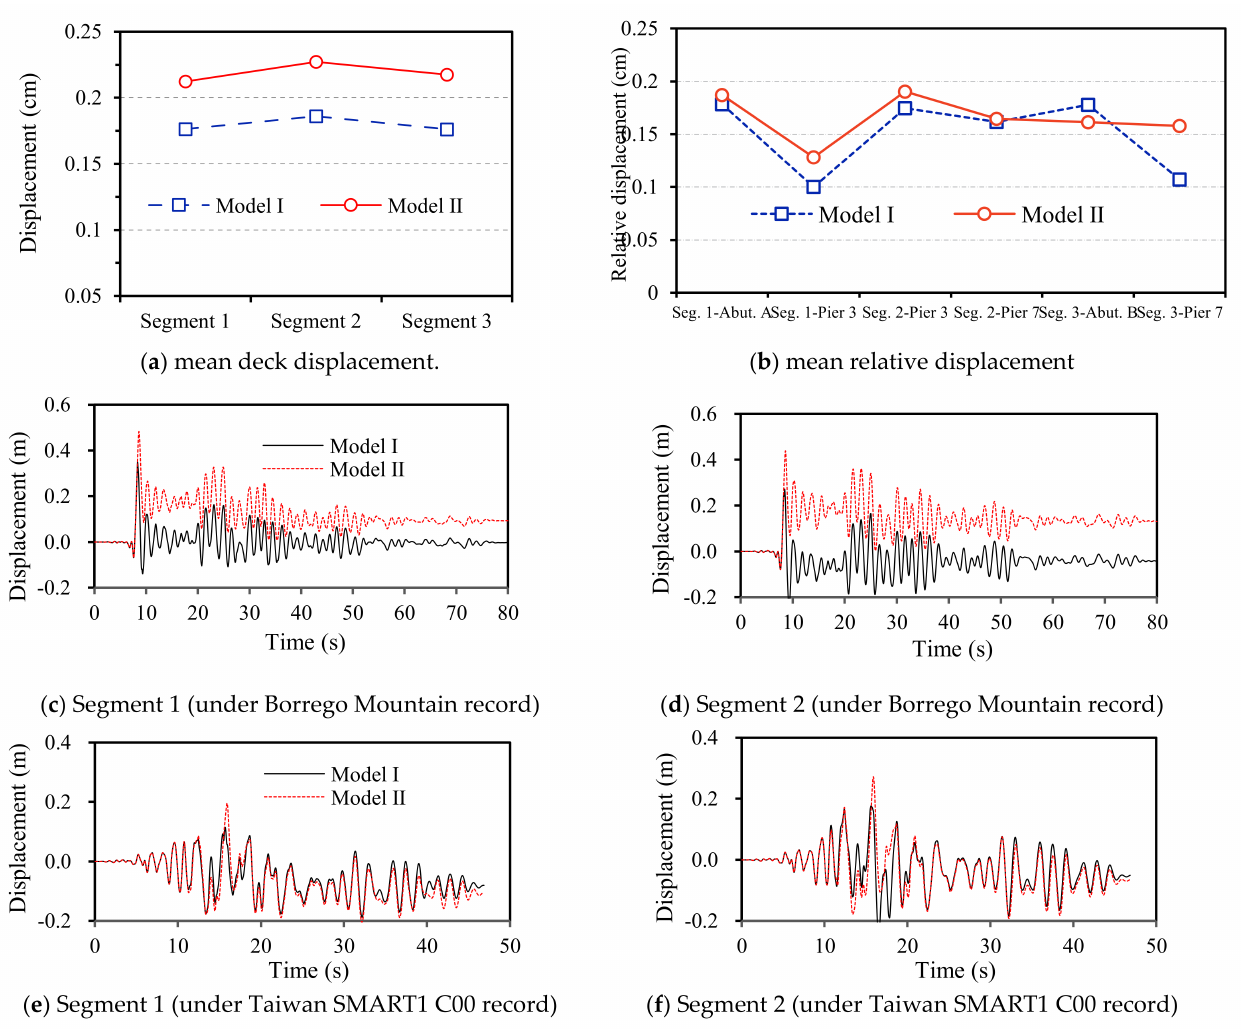
Figure 9. Displacement